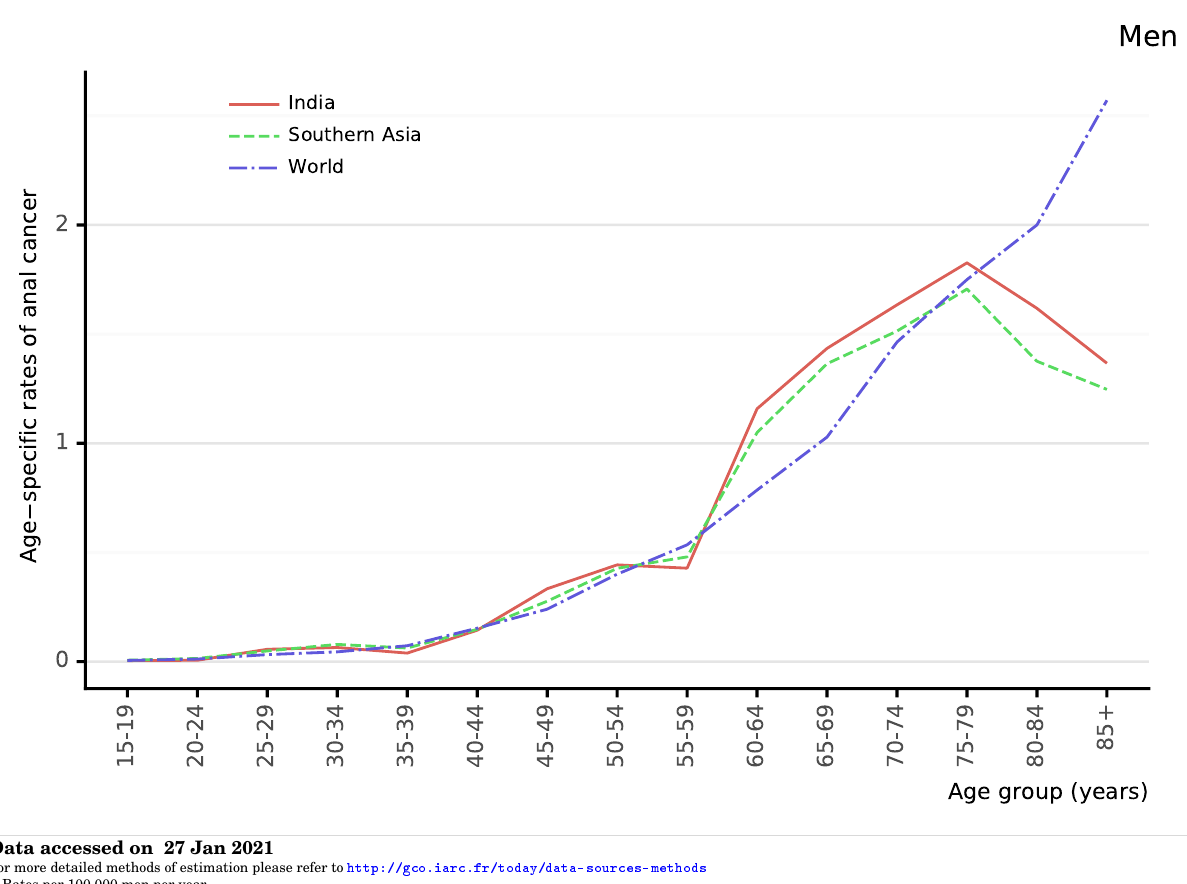
Figure 111: Comparison of age-specific anal cancer mortality rates among men by age in India, within the region, and the rest of